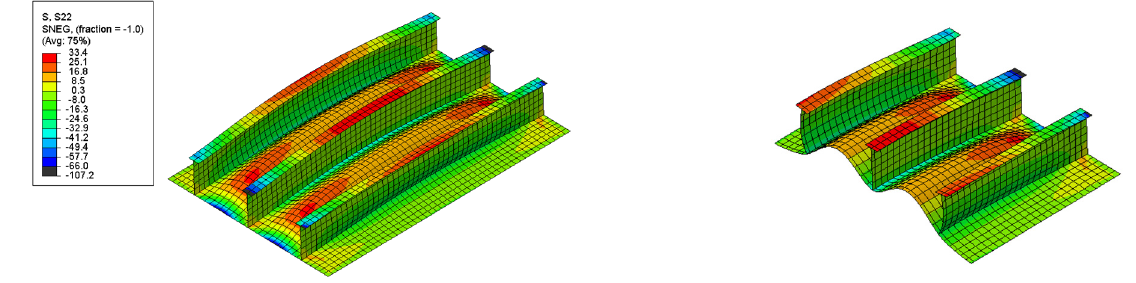
Figure 6. Longitudinal stress distribution (S22 in the model’s convention) over the bottom stiffened panel: left , full model; right , section cut.